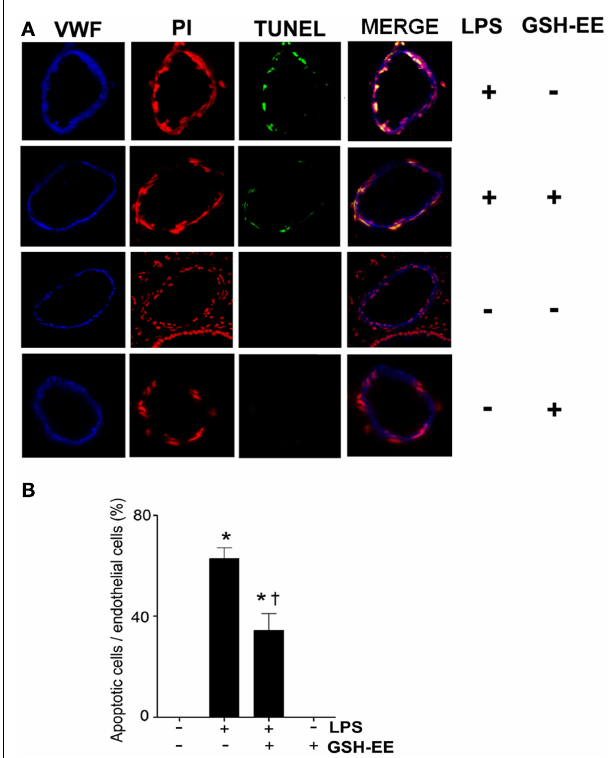
FIGURE 4 | GSH supplementation inhibits the LPS-induced endothelial cell apoptosis in the mouse lung. Lung tissue sections from vehicle, LPS, LPS + GSH-EE, and GSH-EE treated mice were analyzed for the presence of apoptotic nuclei using the DeadEnd FluorometricTUNEL System.The DNA breaks were labeled with fluorescein-12-dUTP (TUNEL; green), and the nuclei were stained using propidium iodide (PI; red).Vascular endothelial cells were labeled with anti-VonWillebrand Factor (VWF; blue) (A) .The quantification of theTUNEL positive endothelial nuclei and total endothelial nuclei was processed by Image-Pro software and presented as a percentage. LPS treatment caused a significant increase in endothelial apoptosis and this was attenuated by GSH-EE pre-treatment (B) .Values are mean ± SEM; n = 4/group. * P < 0.05 vs. vehicle; † P < 0.05 vs.